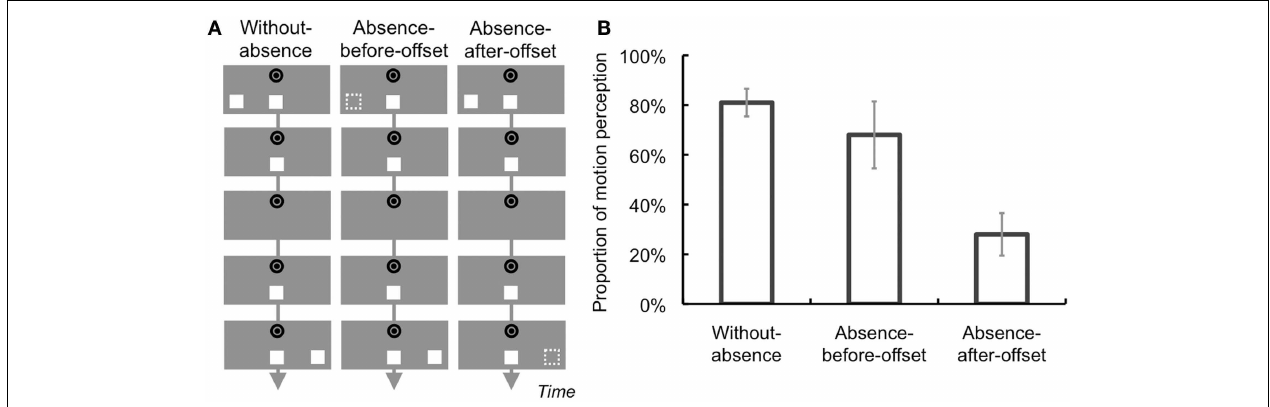
offset in the Absence-before-offset and Absence-after-offset conditions, respectively. (B) Results.The proportion of illusory motion perception of the target was smaller in the Absence-after-offset condition than in the other conditions. Error bars denote standard errors of the mean ( N = 4).